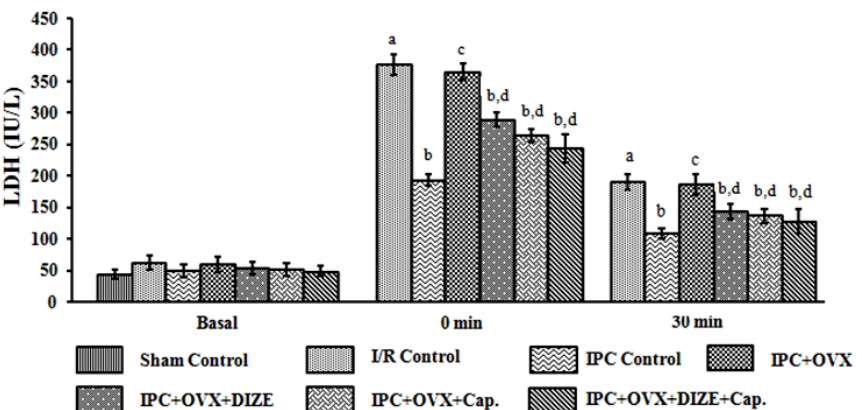
FIGURE 3 - Effect of I/R on the release of LDH, effect of ischemic preconditioning (IPC) on the release of LDH in normal and OVX rat heart, effect of DIZE perfusion on the release of LDH in ovariectomized rat heart and effect of Cap. alone or in combination with DIZE on the release of LDH in OVX rat heart. I/R denotes ischemia reperfusion; IPC denotes ischemic preconditioning; OVX denotes ovariectomy; DIZE denotes diminazene aceturate; Cap. denotes captopril. Values are expressed as mean ± S.D, a = p< 0.05 vs. Sham control; b = p< 0.05 vs. I/R control; c = P< 0.05 vs. IPC in normal rat heart; d = p< 0.05 vs. IPC in OVX rat heart.